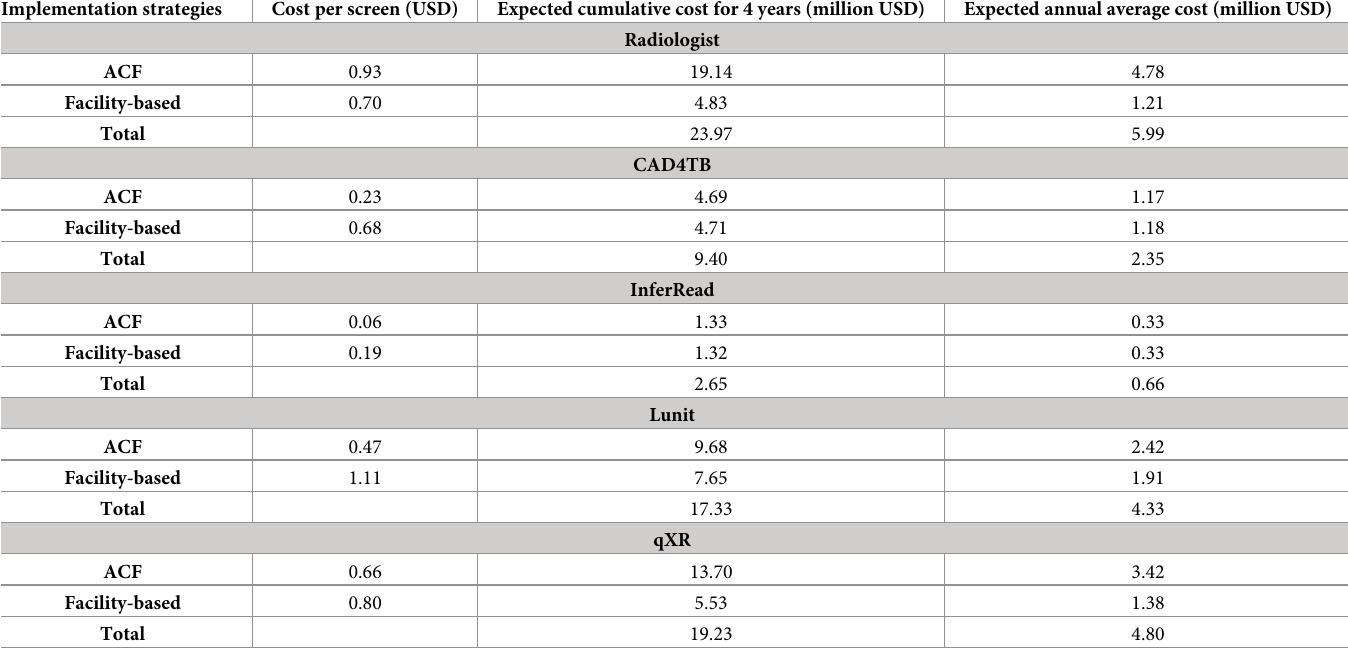
Table 2. Expected incremental cost for scale-up at national